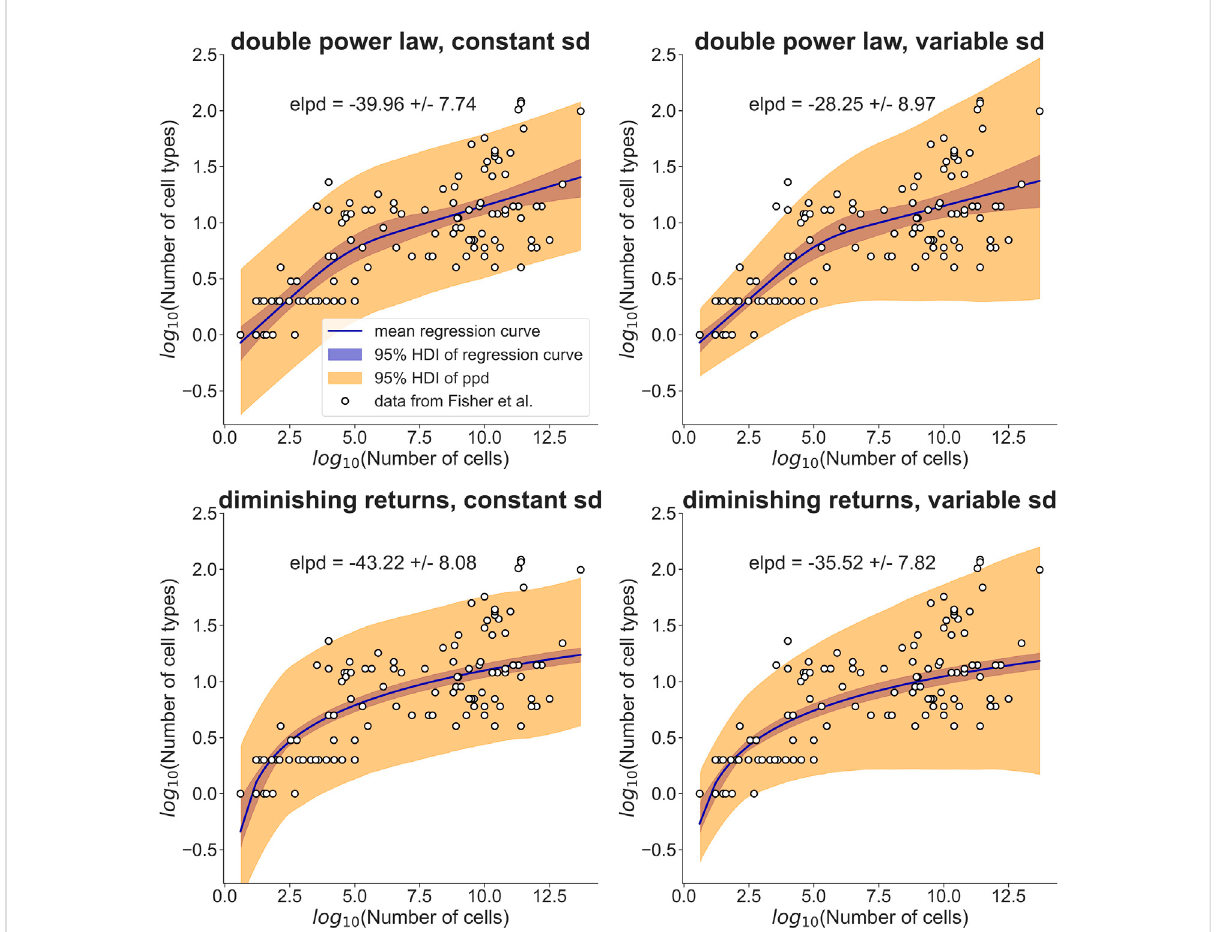
FIGURE 1 A simple model assuming diminishing fi tness bene fi ts of additional cell types performs as well as a double power law in explaining cell type allometry. Fisher et al. (2013, 2020)) collected cell type information for a range of different organisms (open circles). They modeled the observed allometric relationship with separate power laws for small and large organisms (top row). My model explains the observed allometry by a fi tness bene fi t that diminishes with increasing cell type number (bottom row). I used a Bayesian hierarchical modeling approach to compare the two models. The data was assumed to benormally distributed with a standard deviation (sd)that was either constant (left column) or allowedto increase linearly with log 10 (Number of cells) (right column). The regression curves, shown as solid lines, are posterior means of the models, with the 95% highest density interval (HDI) indicated by a blue band. The orange band indicates the HDI of the posterior predictive distribution (ppd). For each model, the expected log predictive density (elpd) is reported together with its standard error. Judging by the elpd, the ‘ diminishing returns ’ model performs about as well as the double power law and the models with variable sd perform slightly better than the models with constant sd. Point estimates and HDIs of all parameters can be found in Table